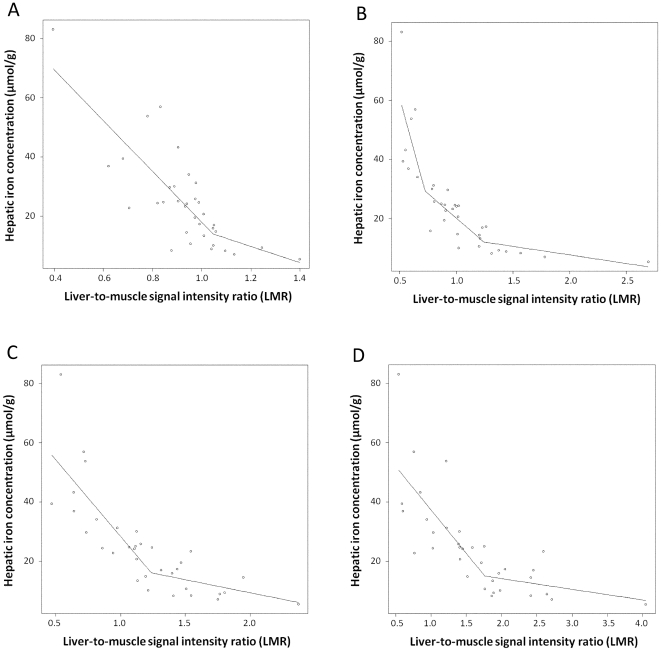
Scatter plots of LMR and hepatic iron concentration (µmol/g dry liver) on T2-GRE (A), T2-EPI (B), DW-EPI-500 (C), and DW-EPI-1000 (D).Correlation between LMR and hepatic iron concentration for linear regression with spline models are shown as solid lines on each sequence. The linear regression model [y = 131.0−139.7×LMR+106.5×(LMR−0.73)++27.4×(LMR−1.24)+] on T2-EPI was optimal.